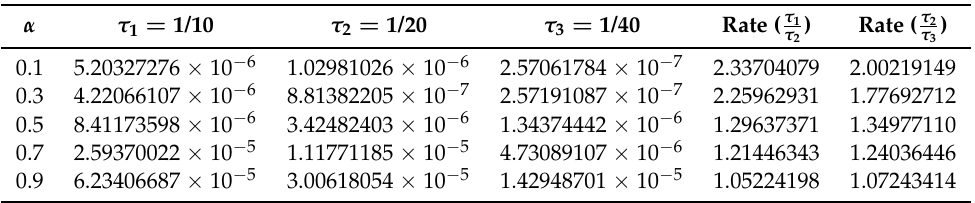
(cid:107) with τ = 1 h